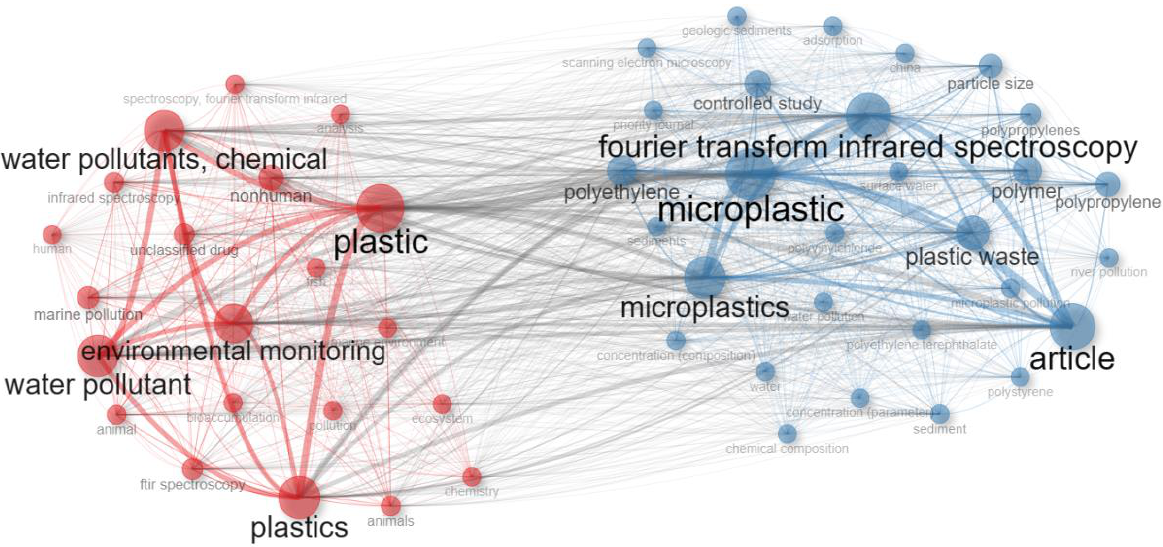
Figure 7. The Co-Occurrence Keyword Analysis for FTIR-related literature. The figure was generated using the open-source tool Biblioshiny for Bibliometrix [38].